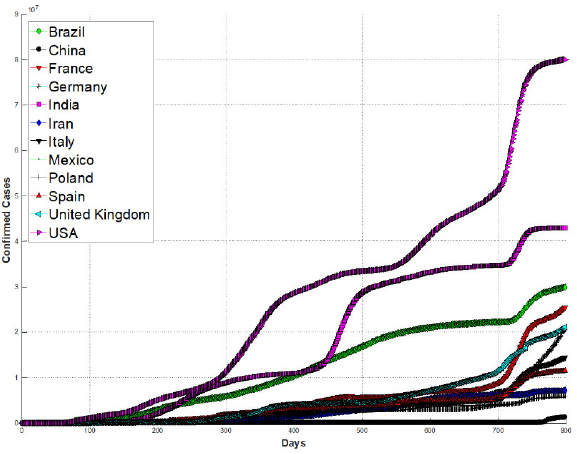
Figure 9. First data period.